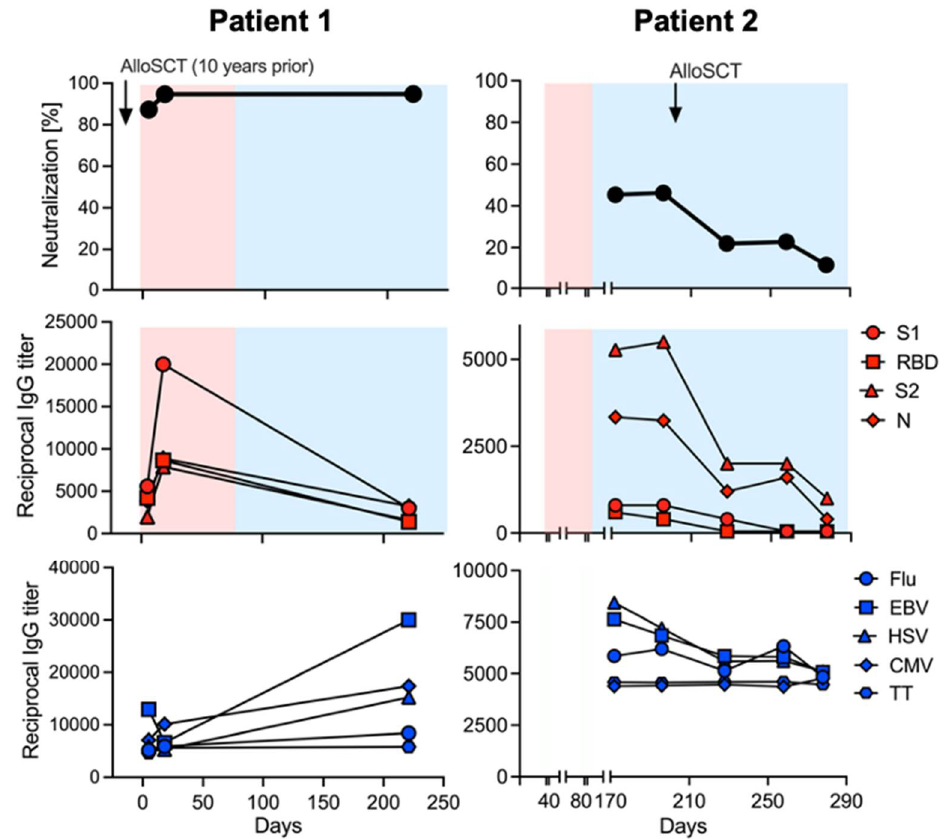
Figure 1. Anti-SARS-CoV antibody responses in two patients receiving allogeneic stem cell trans- plants. Neutralizing the activity of the patients’ serum (upper row, black symbols), antibody titers against the SARS-CoV proteins S1, RBD, S2, and N (middle row, red symbols), as well as titers against control proteins Flu, EBV, HSV, CMV, and TT (lower row, blue symbols) were measured with an ELISA. The timeframe of PCR positivity and negativity for SARS-CoV-2 are indicated by red and blue areas, respectively. The timepoint at which alloSCT was performed is indicated by a small black arrow.